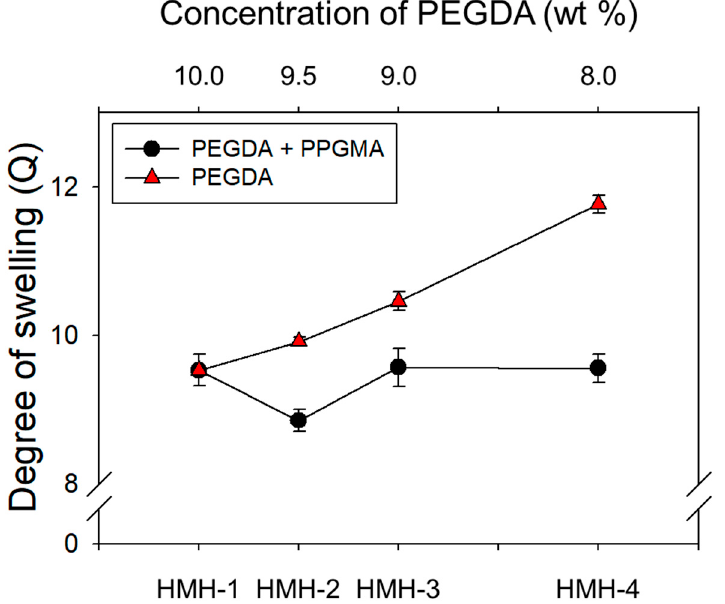
Figure 3. The degree of swelling ( Q ) of the hydrogel was calculated 10% PEGDA-575 hydrogels with decrease mass fraction of PEGDA ( ▲ ), and with increase mass fraction of PPGMA while keeping total polymer concentration constant ( ● ). The hydrophobic chain in the hydrogel was the major cause of decreasing degree of swelling from 9.5 wt % to 10 wt %.